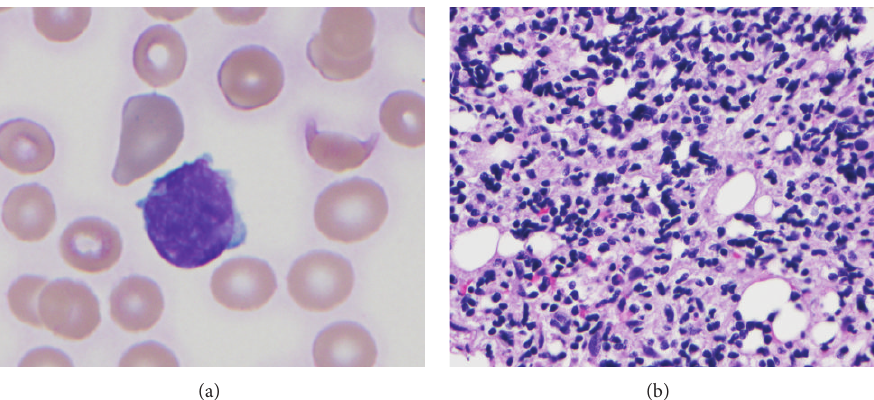
Figure 1: B-Lymphoblastic leukemia. (a) Peripheral blood (Wright-Giemsa, 100x) showing a circulating large sized blast. (b) Bone marrow biopsy(hematoxylin&eosin,50x)showingfibroticmarrowwithsmallareaofimmaturemononuclearcells.Noareasofnormalhematopoiesis were